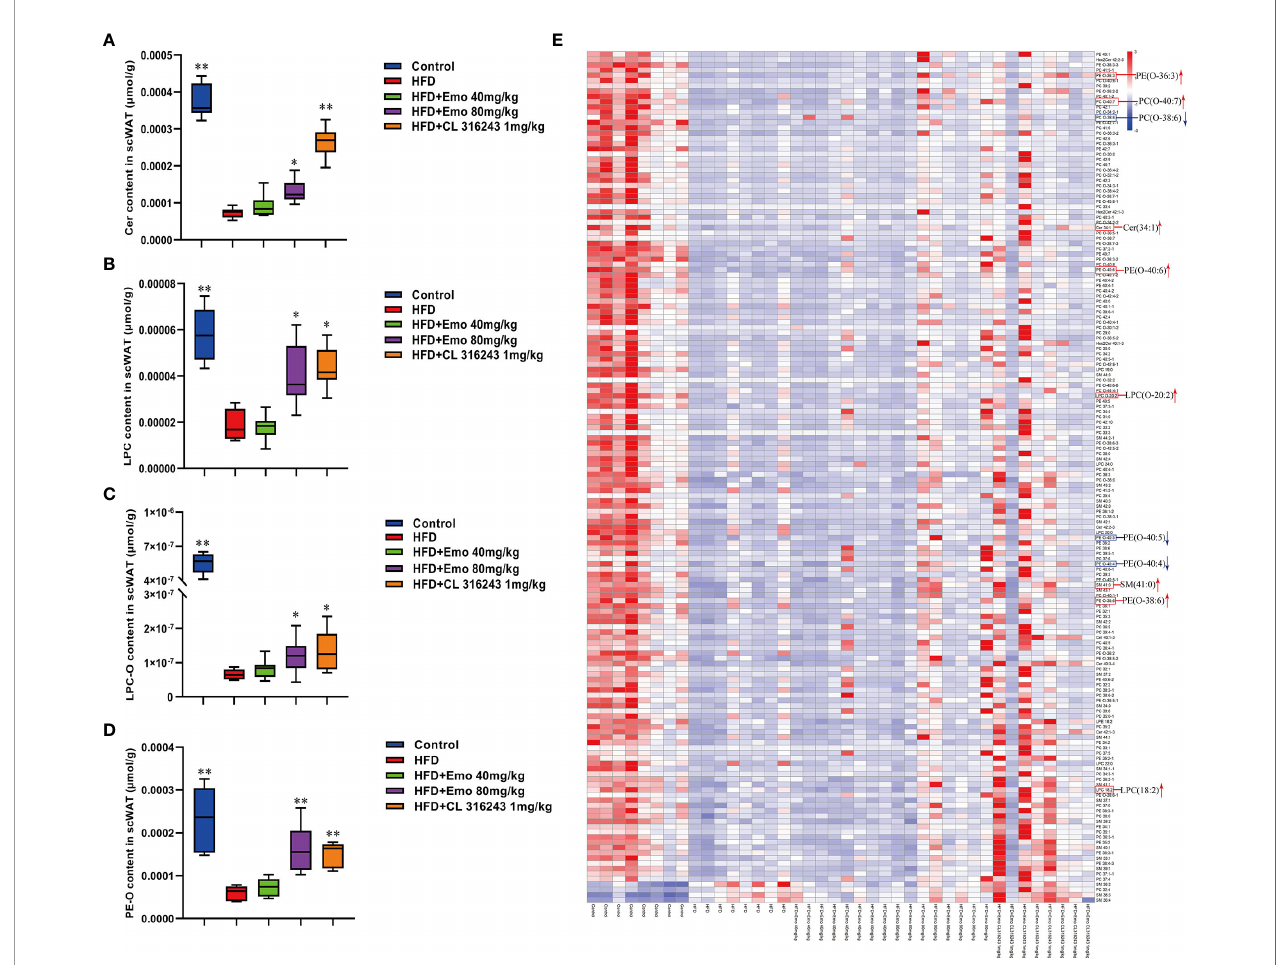
FIGURE 5 | Effects of emodin on the lipid metabolites in scWAT of HFD mice. (A) The content of Cer in scWAT. (B) The content of LPC in scWAT. (C) The content of LPC-O in scWAT. (D) The content of PE-O in scWAT. (E) Heat map. Only metabolites with VIP >1 and P < 0.05 were selected in heat map, and different shades of color present the concentration (red, white and blue presented the high, normal and low concentration). The red up arrow indicates up regulation or promotion, and the blue down arrow indicates down regulation or inhibition. HFD, high fat diet; Emo, emodin; PC, phosphatidylcholine; PE, phosphatidylethanolamine; Cer, ceramides; LPC, lyso-phosphatidylcholine. Data are expressed as mean ± SE. * P < 0.05, ** P < 0.01 vs. HFD